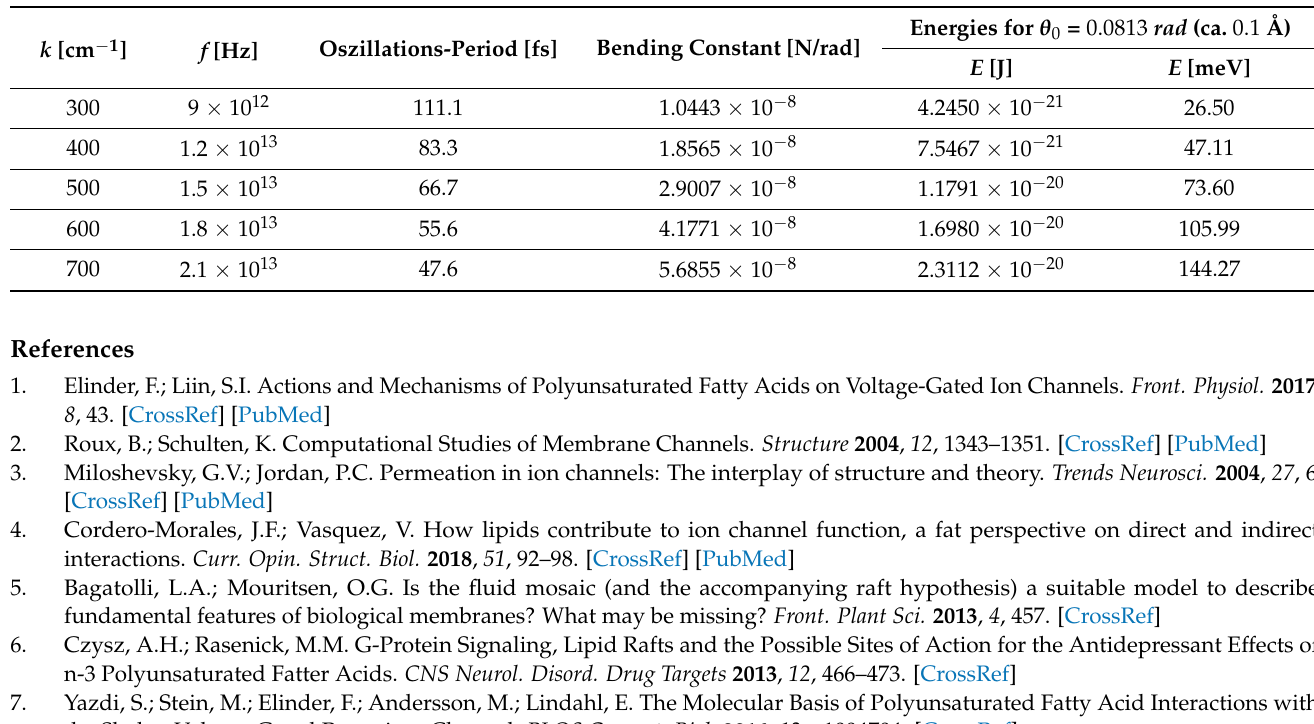
Table A1. Carbonyl Oscillations at Different Wave